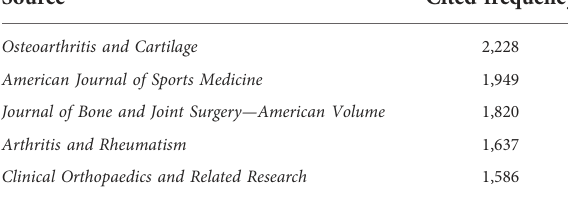
Table 3 , generated by CiteSpace, reveals the citations of journals